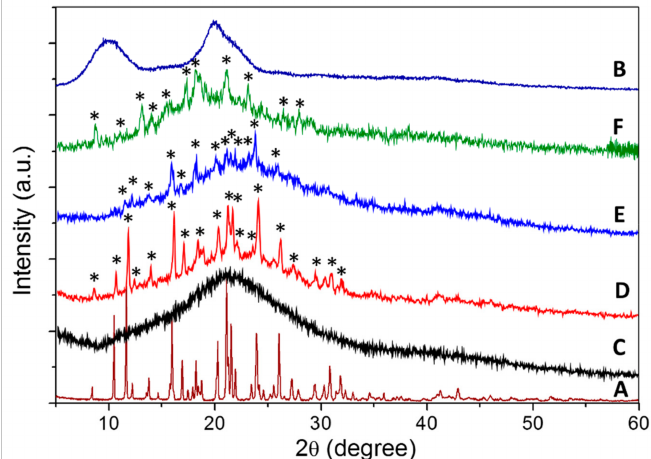
Figure 1. Powder XRD patterns of ( A ) pure hexaconazole, ( B ) CEN and chitosan–hexaconazole nanoparticles prepared at various concentrations of TPP, ( C ) 2.5, ( D ) 5, ( E ) 10, and ( F ) 20 mg / mL. The asterisk represents the hexaconazole